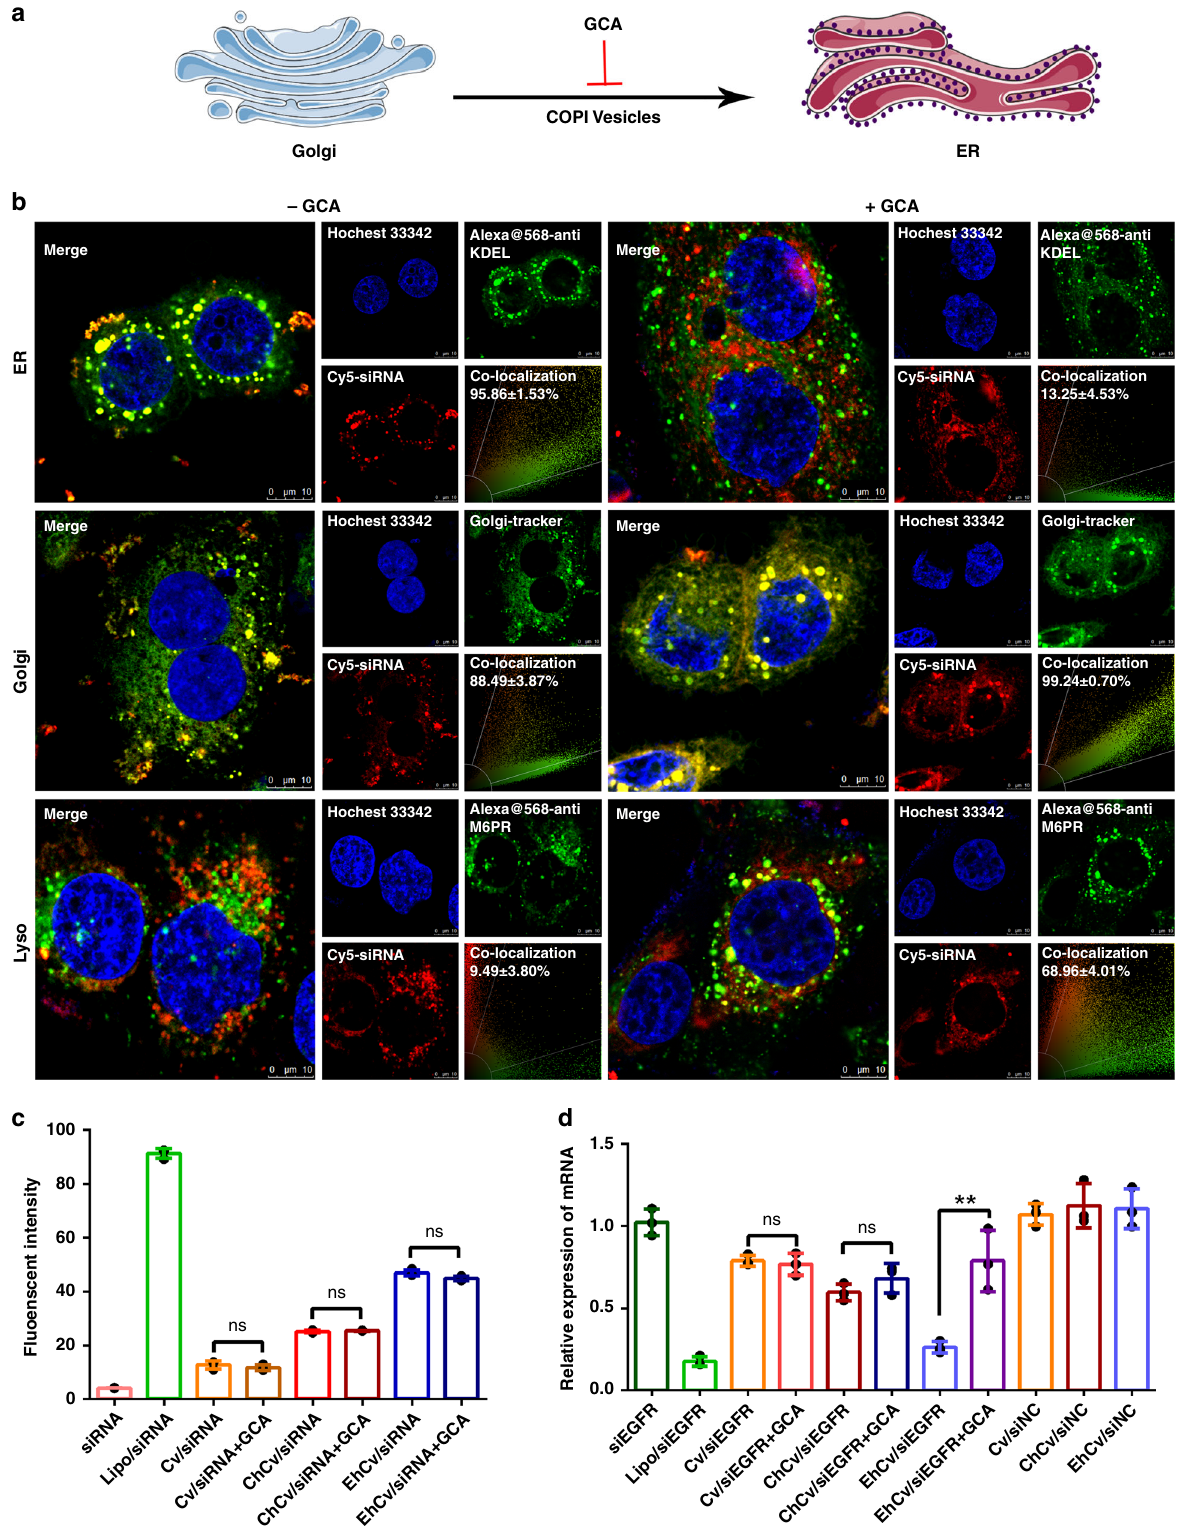
Fig. 6 Veri fi cation of the retrograde transport pathway of EhCv/siRNA NPs from Golgi to endoplasmic reticulum (ER): a Illustration of Golgicide A (GCA) inhibition; b Representative colocalization pictures of EhCv/siRNA NPs in ER, Golgi apparatus, and lysosomes with or without GCA treatment, c Cellular uptake and d epidermal growth factor receptor (EGFR) mRNA levels in the cells treated by EhCv/siRNA NPs with or without GCA treatment (10 μ M). Golgi, ER, and lysosomes were stained by Golgi-tracker, Alexa Fluor @ 568-labeled anti-KDEL, and anti-M6PR antibody, respectively. The fi nal concentration of FAM-siNC, Cy5-siNC, and siEGFR were 100 nM. Data are shown as mean ± SD ( n = 3). ** p < 0.01, t